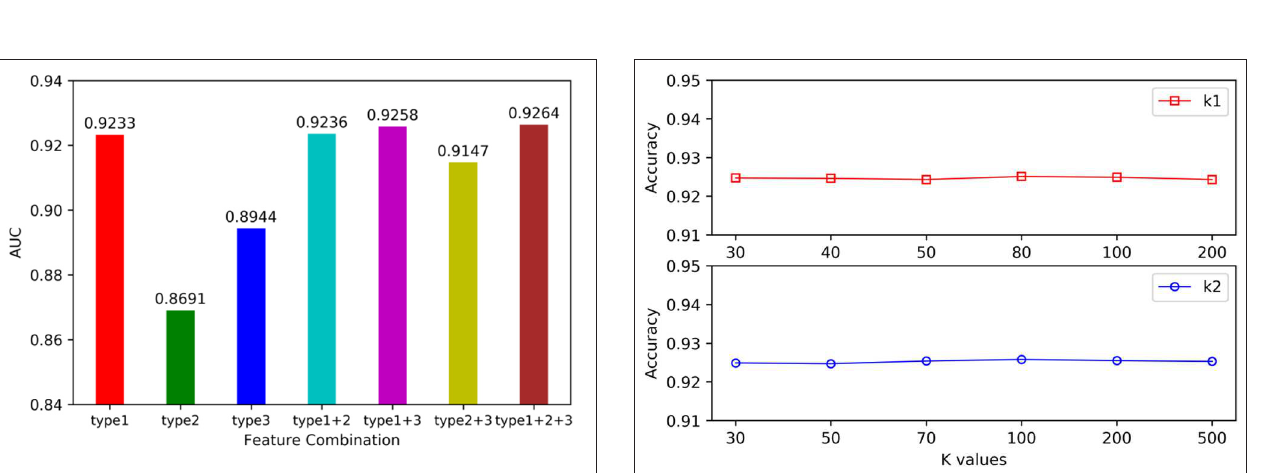
FIGURE 3 | The effect of varying k values on the MSCHLMDA